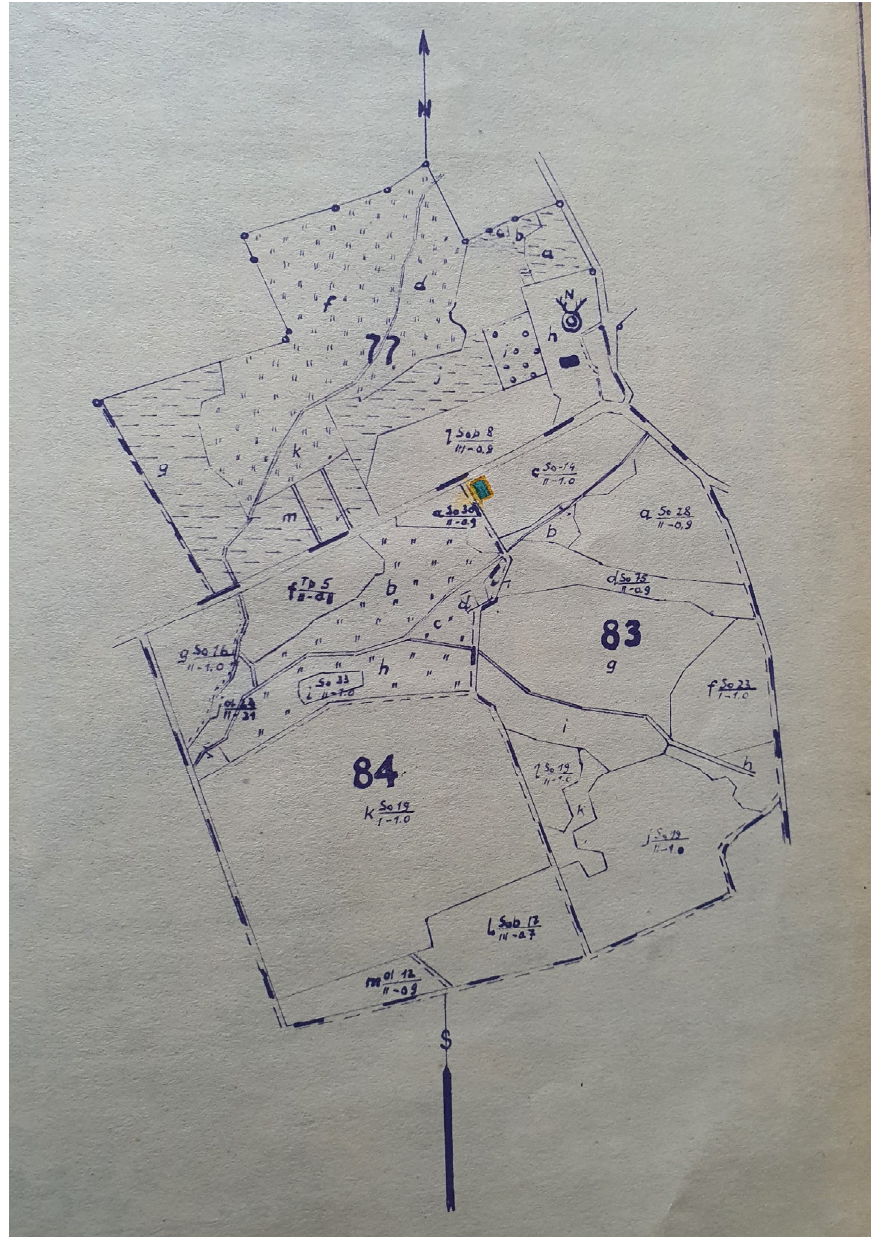
Figure A3. Map of the plot in 1951 (historical data). Table A1. Dimensions of sample trees at the age of 35 years (historical data). Dimensions of Sample Trees at the Age of 35 Years Tree I Tree II Tree III Tree